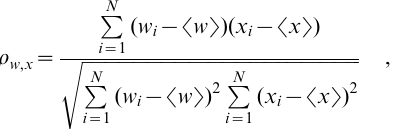
Table S1 Comparison of power law exponent a of the Pardus wealth distribution to real world data. Table S2 Linear regression model for wealth. Data taken at days 240, 480, 720, 960, and 1200 after the beginning of the game. (cid:3) p value v 0 : 05, (cid:3)(cid:3) p value v 0 : 01, (cid:3)(cid:3)(cid:3) p value v 0 : 001,